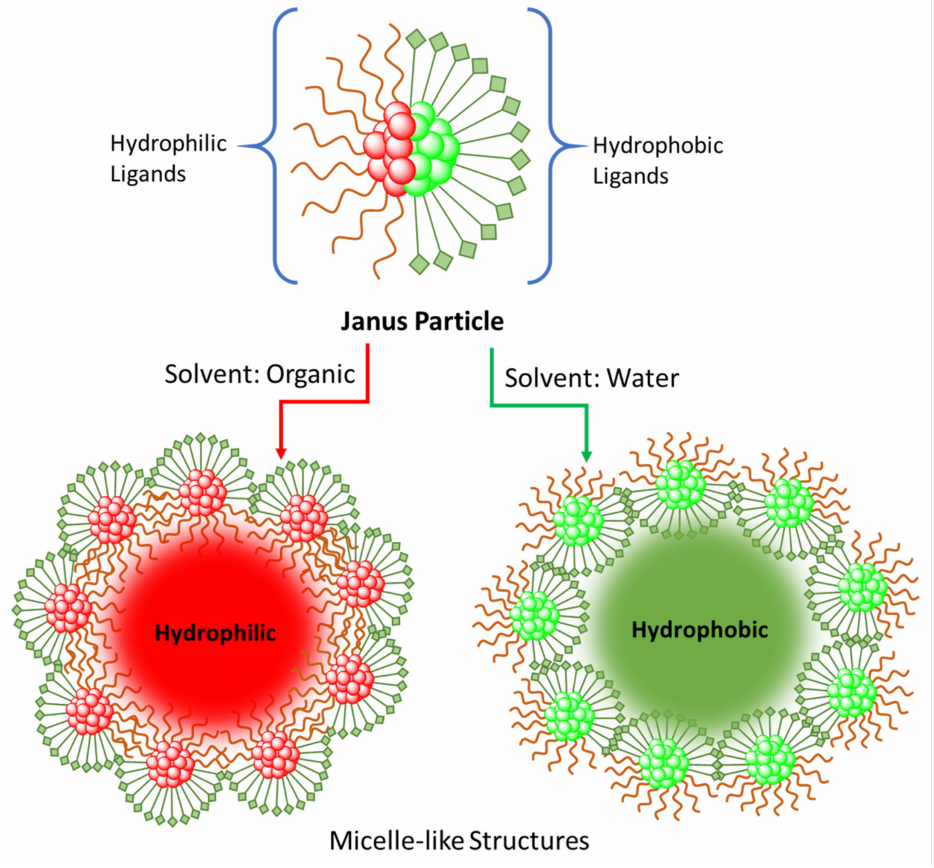
Figure 8. Schematic representation of phase transfer via Janus nanoparticles [38]. Scheme derived from work described in